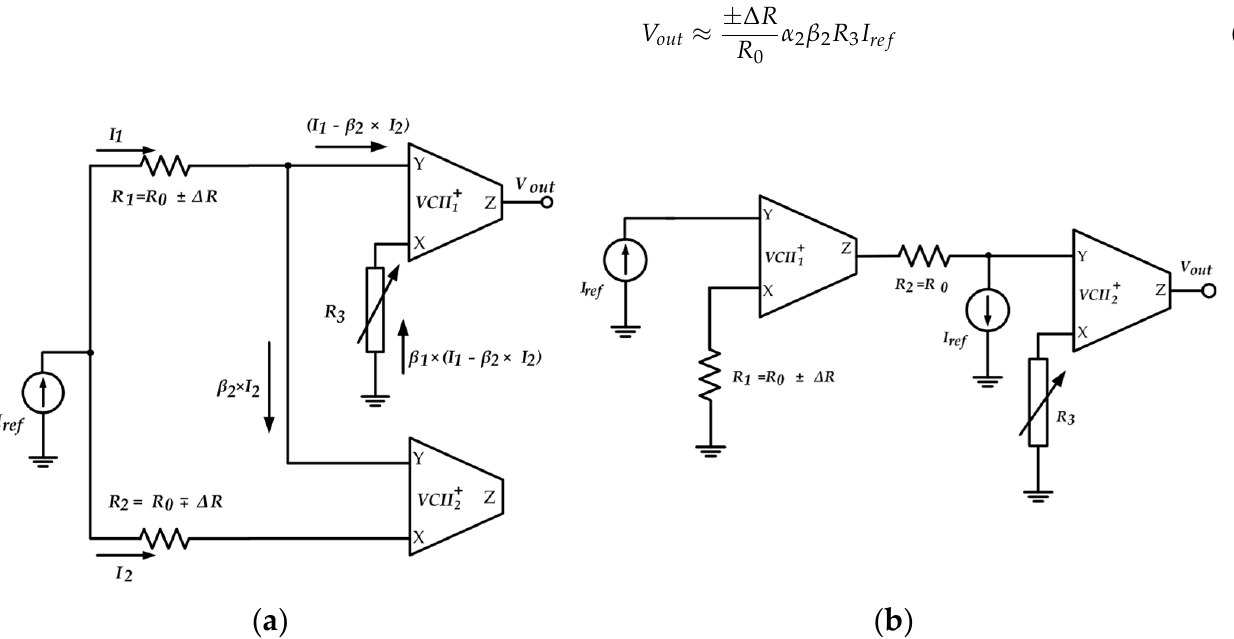
Figure 6. VCII-based interface circuit for CMWB [9] for ( a ) two-sensor and ( b ) one-sensor applica- tions.